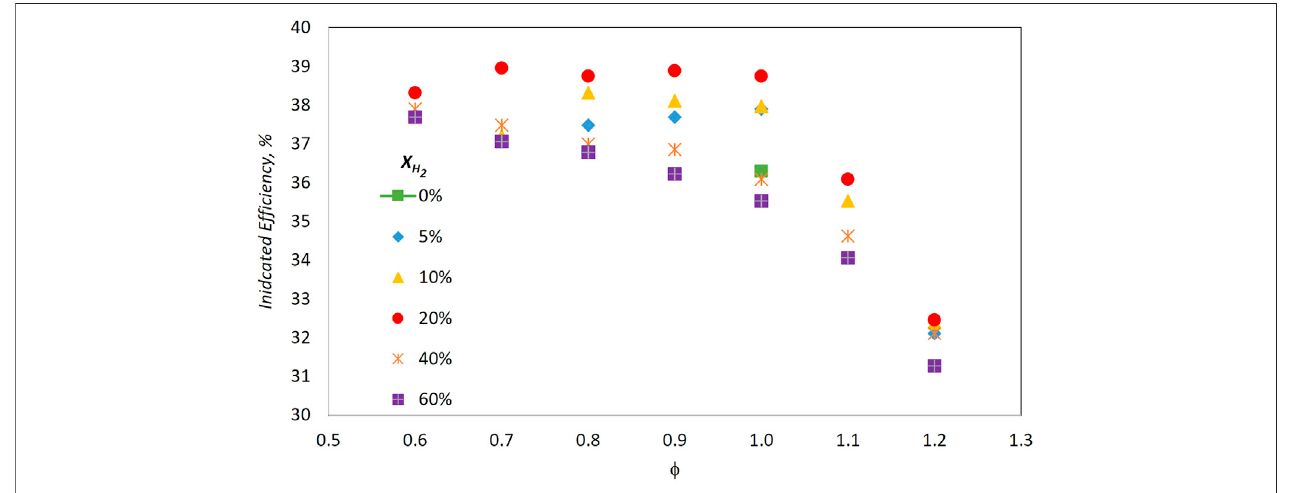
FIGURE 6 | Indicated ef fi ciency as a function of equivalence ratio ϕ under different hydrogen concentrations (Lhuillier et al.,